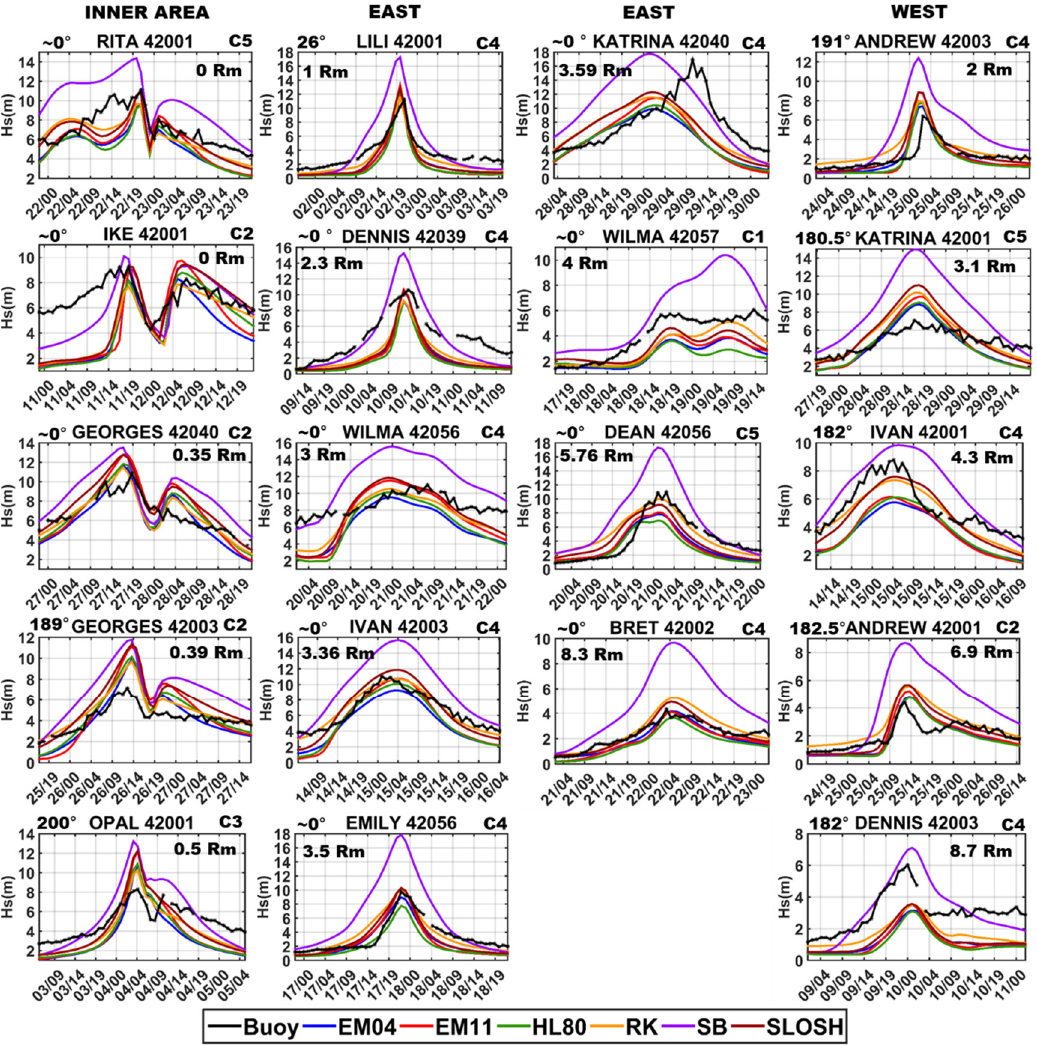
Figure 7. Significant wave height ( Hs ) time series measured from NDBC buoys and estimated from parametric models, for the selected tropical cyclones. Data in each figure: upper left corner: the angle between track and buoy (in degrees from TC translation direction to buoy and positive clockwise); right upper corner category; distance (as a function of R mw ) from the TC center to the buoy in the nearest time step. The subplots are grouped in columns according to the buoy location related to the TC center (the inner region, when the buoy is inside areas minor than R mw and east and west buoy’s position respect the translation direction of the TC). The x -axis shows the date of the time series in day/hour format (DD/HH).